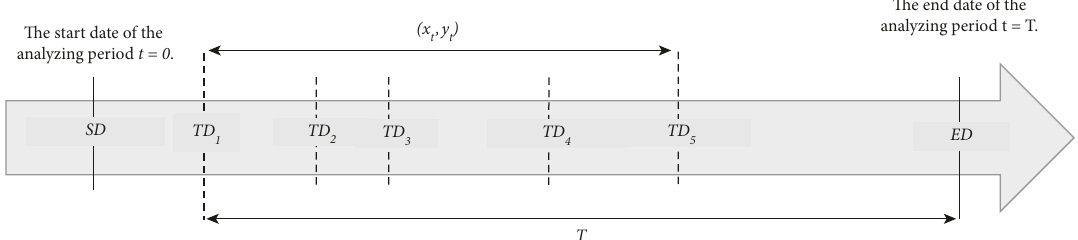
Figure 1: Notations for converting to RFM data in the